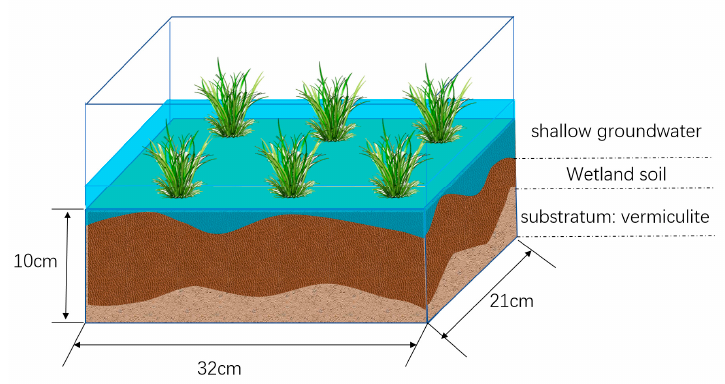
Figure 3. Schematic diagram of the controlled growth experiment design.